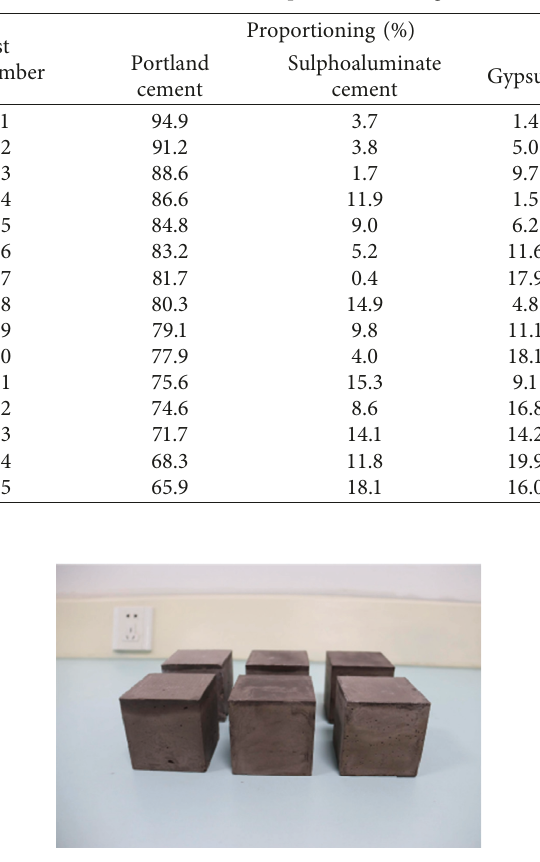
Table 4: Testing instruments for composite cementing material. Table 5: Formulations of composite cementing material.